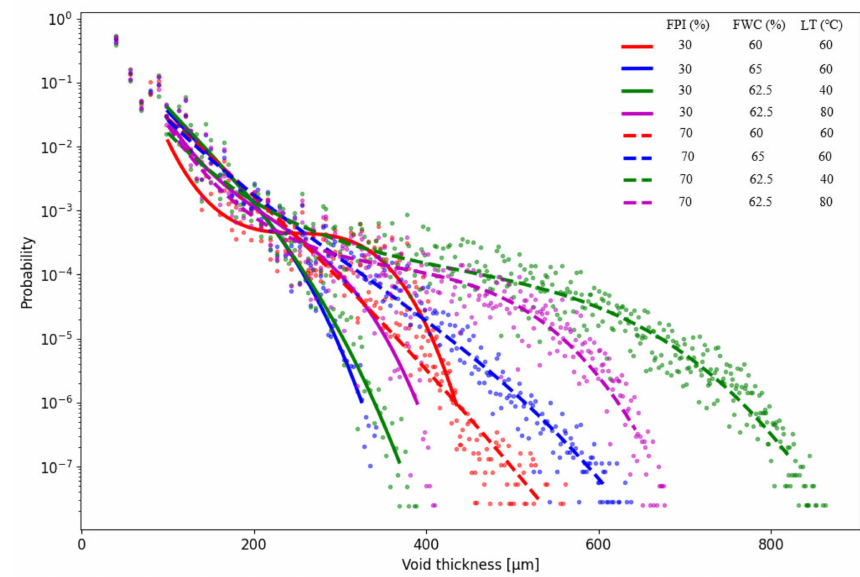
Figure 7. Results from the measurement of the void thickness of the meat analogues containing 30% and 70% FPI (faba bean protein isolate) at various feed water contents (FWC) and long cooling die temperatures